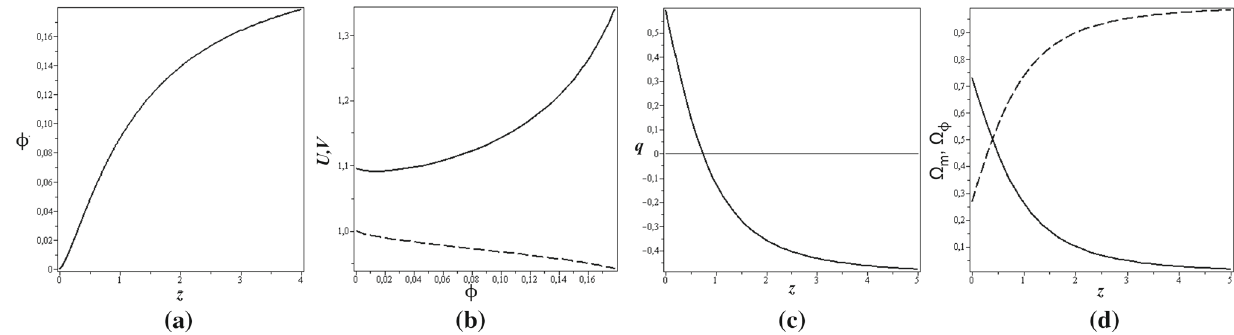
Fig. 3 a Plot of φ as a function of z . b Plot of V (solid curve) and U (dashed curve) as a function of φ . c Plot of q as a function of z . d Plot of Ω φ (solid curve) and Ω m (dashed curve) as a function of z . This is for CPL parametrization, with φ 0 = 0, H 0 = 1, ω 0 = − 1, ω 1 = 0 . 1 and Ω m 0 = 0 . 27